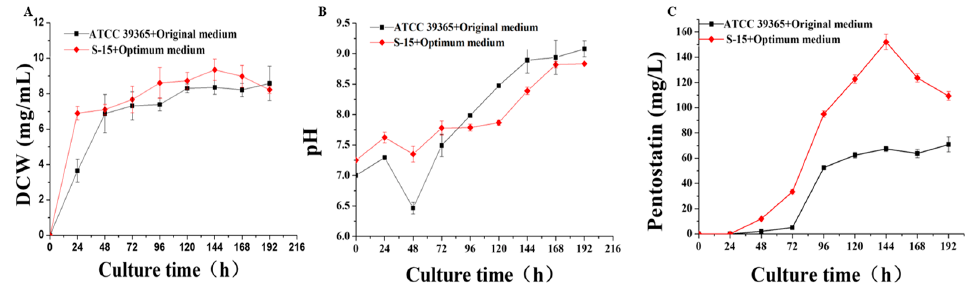
Figure 8. Di ff erences in the fermentation performance with respect to biomass ( A ), pH ( B ) and pentostatin production ( C ) between Actinomadura sp. S-15 and Actinomadura sp. ATCC39365 in the original medium and optimum medium.